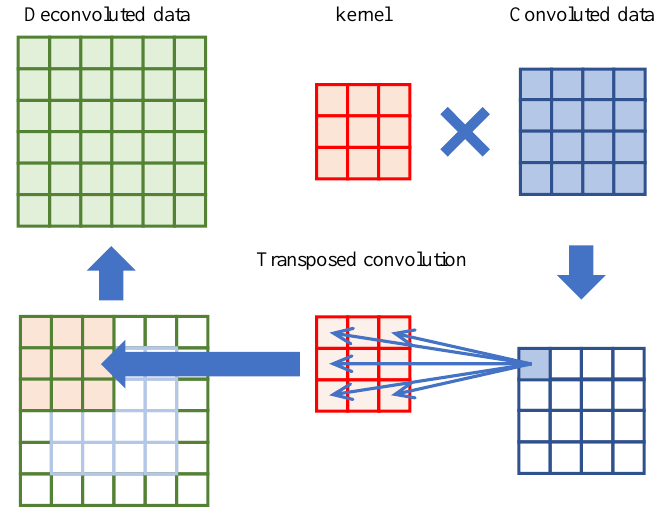
Figure 2. 2D transposed convolution architecture.